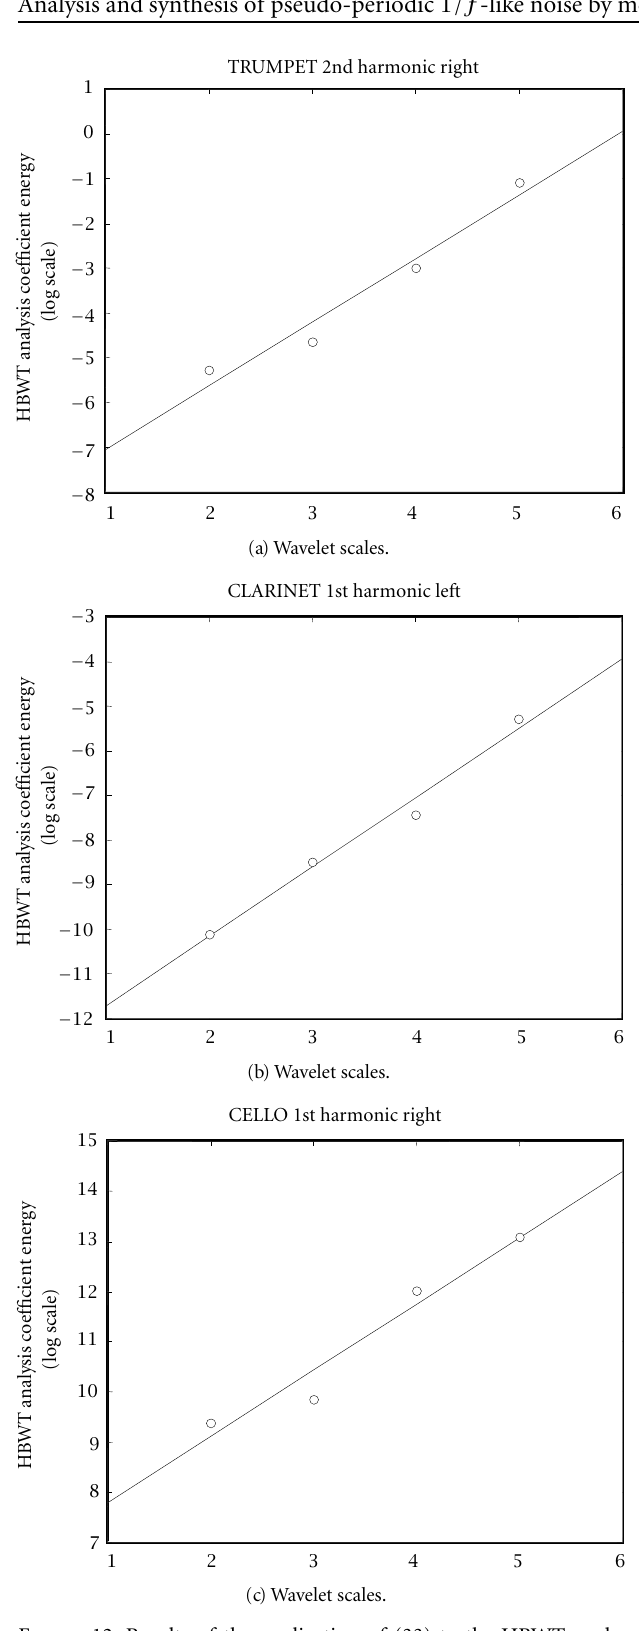
Figure 12: Results of the application of (33) to the HBWT anal- ysis coefficients of three different instruments (2nd, 3rd, 4th, and 5th subbands). Correlation coefficients: (a) 0 . 9790 (b) 0 . 9911 (c) 0 . 9739